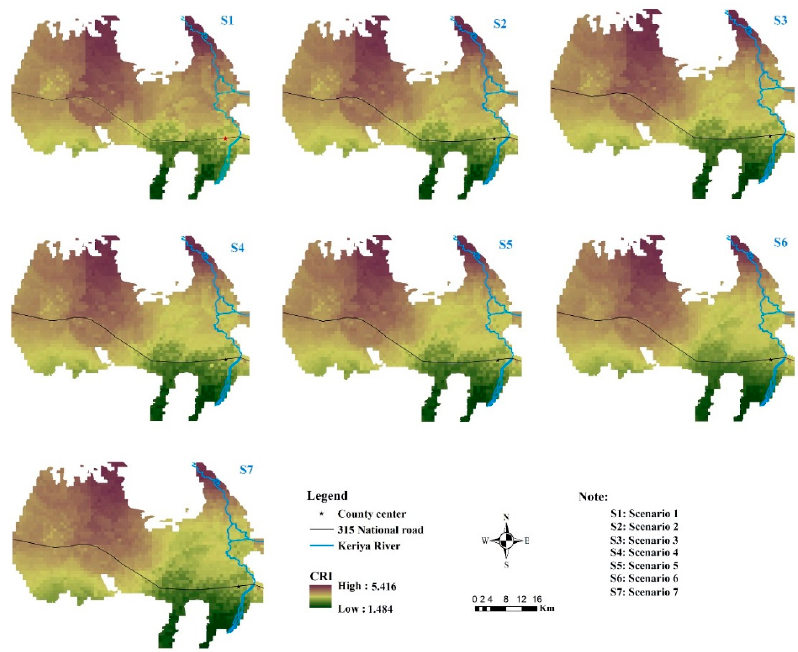
Figure 6. Scenario validation result.